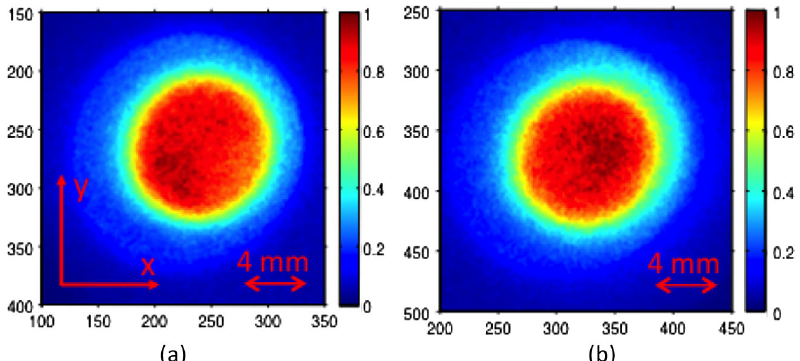
FIG. 12. Comparison of normalized beam images with (a) all DMD pixels set to ‘‘on’’ and Scheimpflug compensation; (b) simple mirror and no compensation.